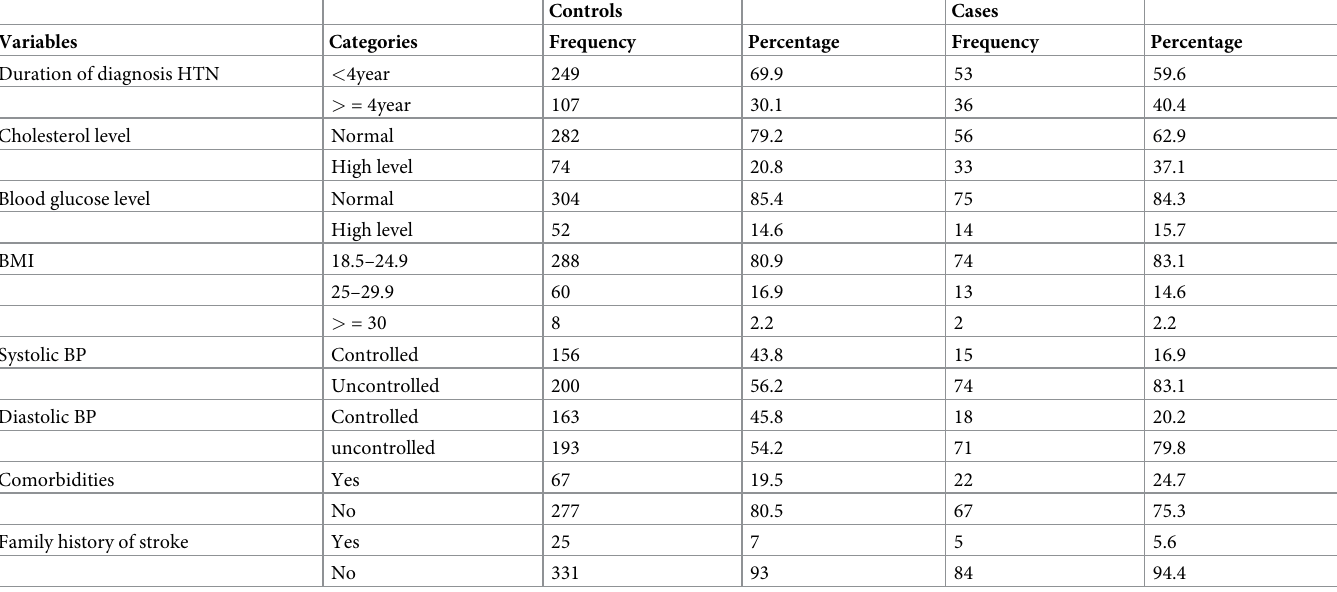
Table 3. Clinical and anthropometric measurements of the study